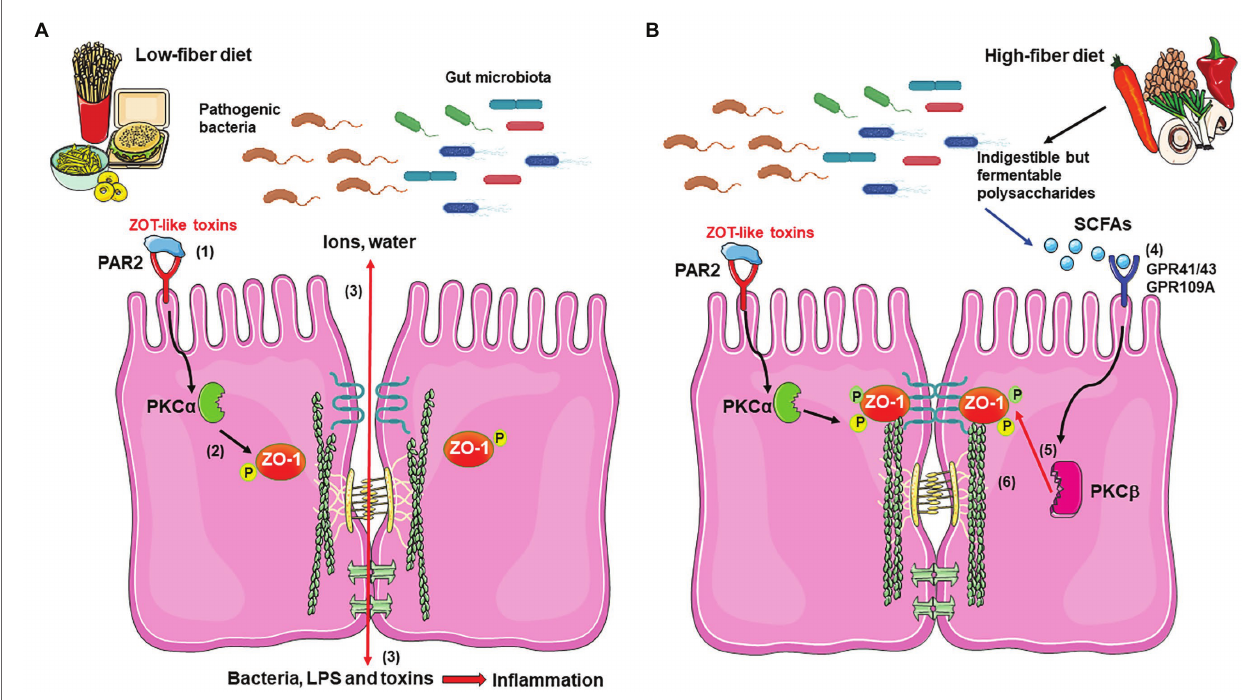
FIGURE 1 | Proposed mechanism for short-chain fatty acids (SFCAs) effects in improvement of the epithelial barrier damaged by bacterial Zot-like toxins. (A) During infection with pathogenic bacteria and in the presence of a low-fiber diet, Zot-like toxins interact with PAR-2 (1), which signals and activates PKC α (2). PKC α catalyzes the phosphorylation of ZO-1 at specific residues, which disconnects it from occludin, claudin, and F-actin (2), with the subsequent loss of tight junction (TJ) integrity. The disassembling of TJ allows the massive filtration of ions and water into the lumen of the intestine, as well as the entry of bacteria and bacterial components, such as LPS and other toxins, which promotes a severe inflammatory response (3). (B) The possible activation of GPR41, GPR43, and/or GPR109A by acetate, propionate, and butyrate produced by gut microbiota from dietary fiber (4) activates PKC β (5), which phosphorylates ZO-1 at different residues than PKC α , allowing its reconnection with occludin, claudin, and F-actin (6), thus recovering the structure and function of the TJ and counteracting the Zot effect. The figure was produced using Servier Medical Art